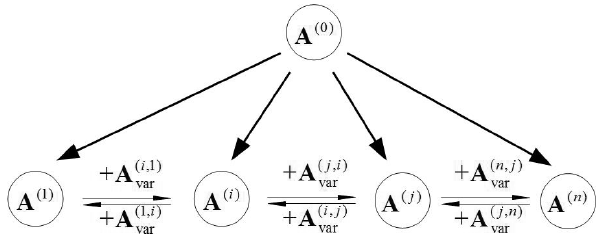
Figure 4. The relationship between the original metamorphic mechanism and sub-configurations.